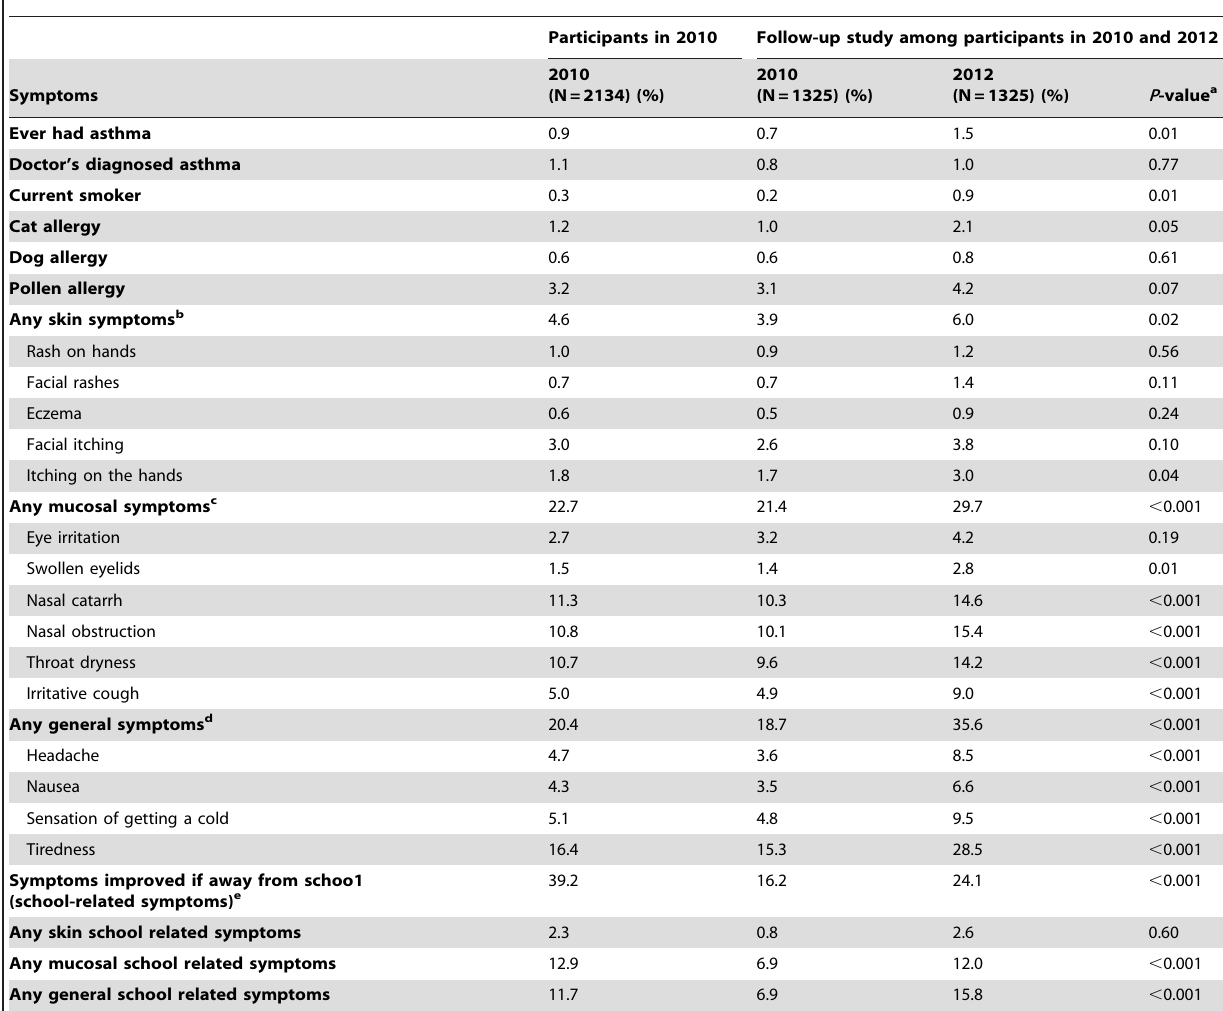
Table 2. The prevalence of asthma, allergy, smoking and weekly symptoms in the last 3 months 2010 and 2012 among junior high school students in